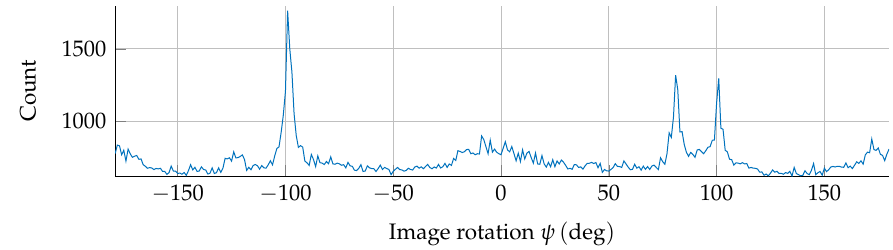
Figure 8. Recovering the unknown image rotation in the case of unavailable or inaccurate UAV IMU data. Extending the proposed method by transforming UAV feature points with multiple rotation values before the histogram voting step. The figure shows the rotation histogram for the Container dataset. The maximum number of raw matches represents unknown image